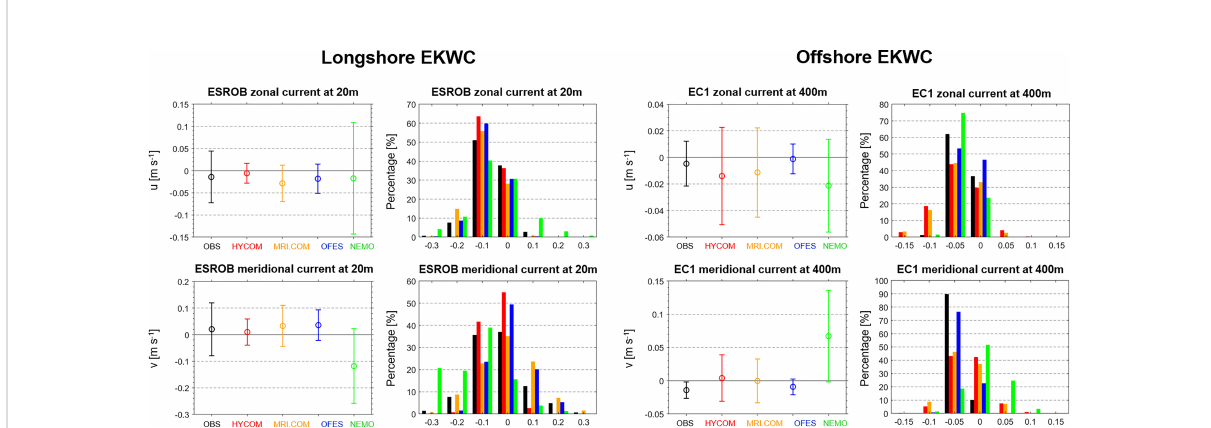
FIGURE 13 Mean current velocities with their standard deviations as well as relative frequency of these velocities from geostationary observations (black) from and model simulations (colors) at 20 m depth of the ESROB station located near the longshore branch of EKWC (left) and at 400 m depth of the EC1 located near the offshore branch of EKWC (right). Results for zonal components are shown in the top panels and for meridional components in the bottom panels. See text for further